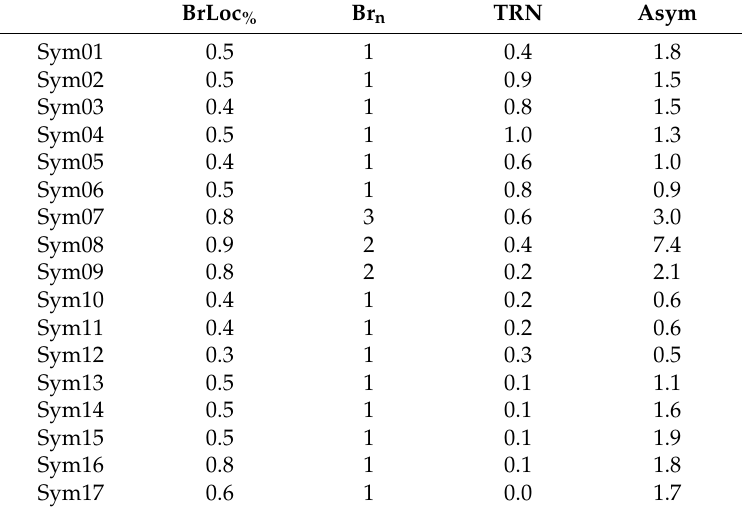
Table 2. Classification of the hyetographs according to the four defined criteria: location of the heaviest burst within the storm period (BrLoc qtl ), percentage of the total storm period that has occurred at the start of the heaviest burst (BrLoc % ), number of bursts (Br n ), hyetograph triangularity (TRN), asymmetry of the storm (asym). BrLoc % Br n TRN Asym Sym01